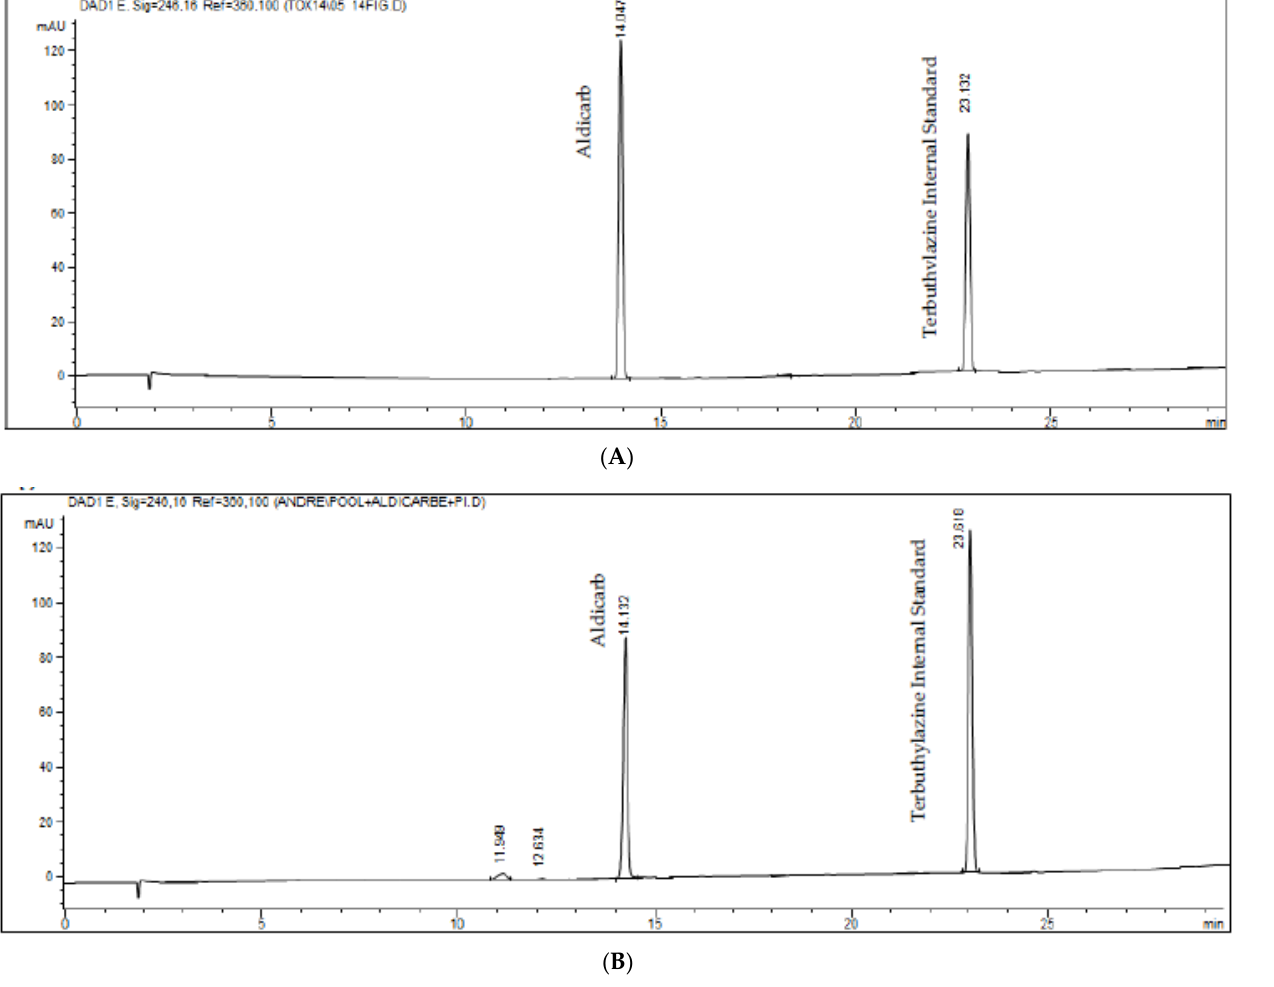
Figure 4. ( A , B ). Chromatograms of the white sample added from the internal standard and the aldicarb figure ( A ). Standard was added in a pool of all the matrices evaluated and the actual sample figure ( B ). Table 14. Coefficient of variation (CV) of the lower limit of quantification (LLQ) and the superior limit of quantification (SLQ), as well as the average CV (average of the CV of the other points of the calibration curve), and of the internal standard (ISD) in the different matrices, expressed in percentage of